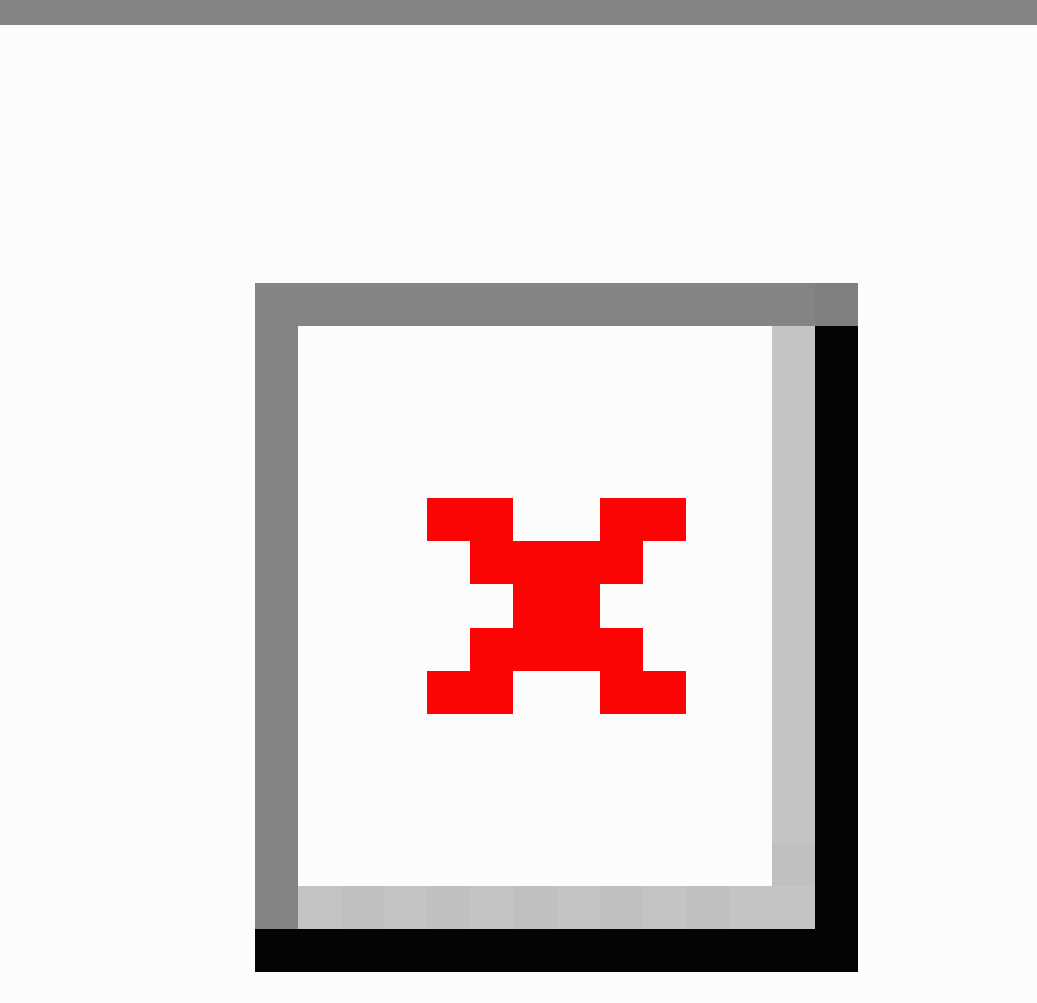
Figure 1. Example GPS location data, overlaid on satellite image. Each small circle represents a histogram bin, which has a size of 500 by 500 meters. The colors indicate the number of samples captured by each bin (brighter means more samples). The bigger blue circles show the center of the clusters detected by the clustering